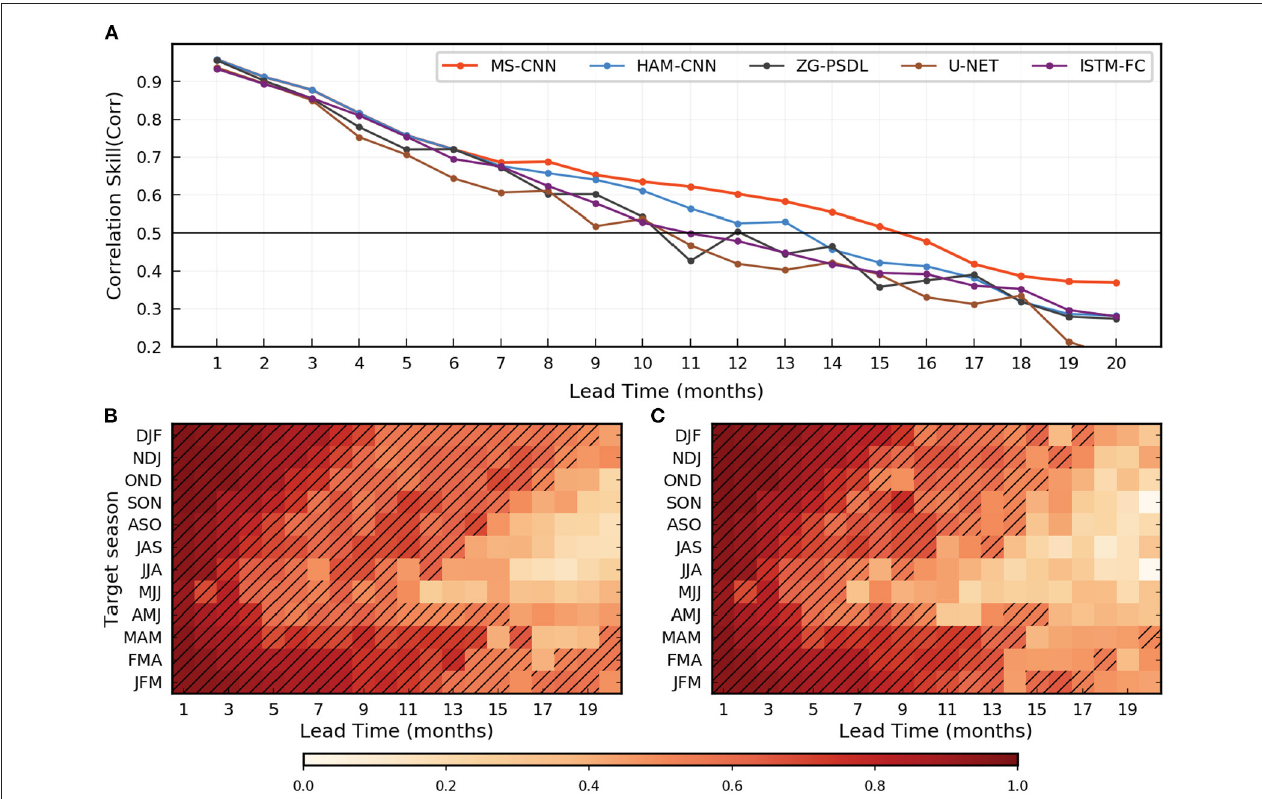
FIGURE 8 | Multi year El Nino-Southern Oscillation (ENSO) forecasts Corr in the MS-CNN model. (A) The all-season correlation skill of the 3-month-moving-averaged Nino3.4 index as a function of the forecast lead month in the model (red), HAM-CNN model (blue), ZG-PSDL(black), and U-net model(brown). (B,C) The correlation skill of the Nino3.4 index targeted to each calendar month in the MS-CNN model (B) and the HAM-CNN model (C) . Hatching highlights the forecasts with correlation skills exceeding 0.5.